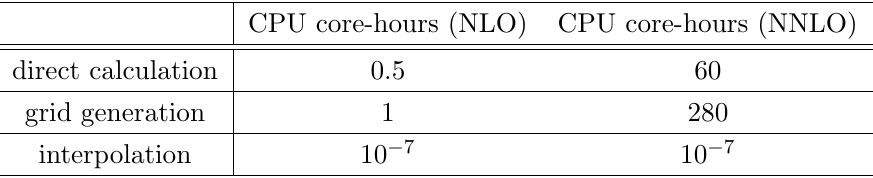
Table 1 . Typical time cost (in CPU core-hours) for calculation and interpolation of reduced cross